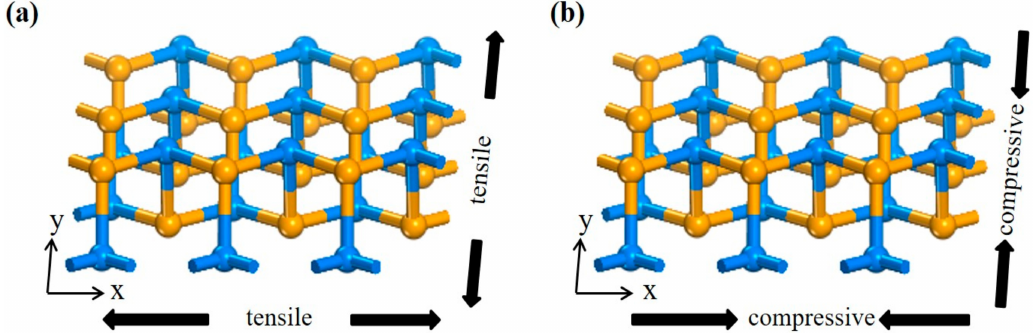
Figure 5. Schematic diagram of SiSe monolayer under in-plane ( a ) compressive ( b ) tensile stress from X-axis, Y-axis, and biaxial